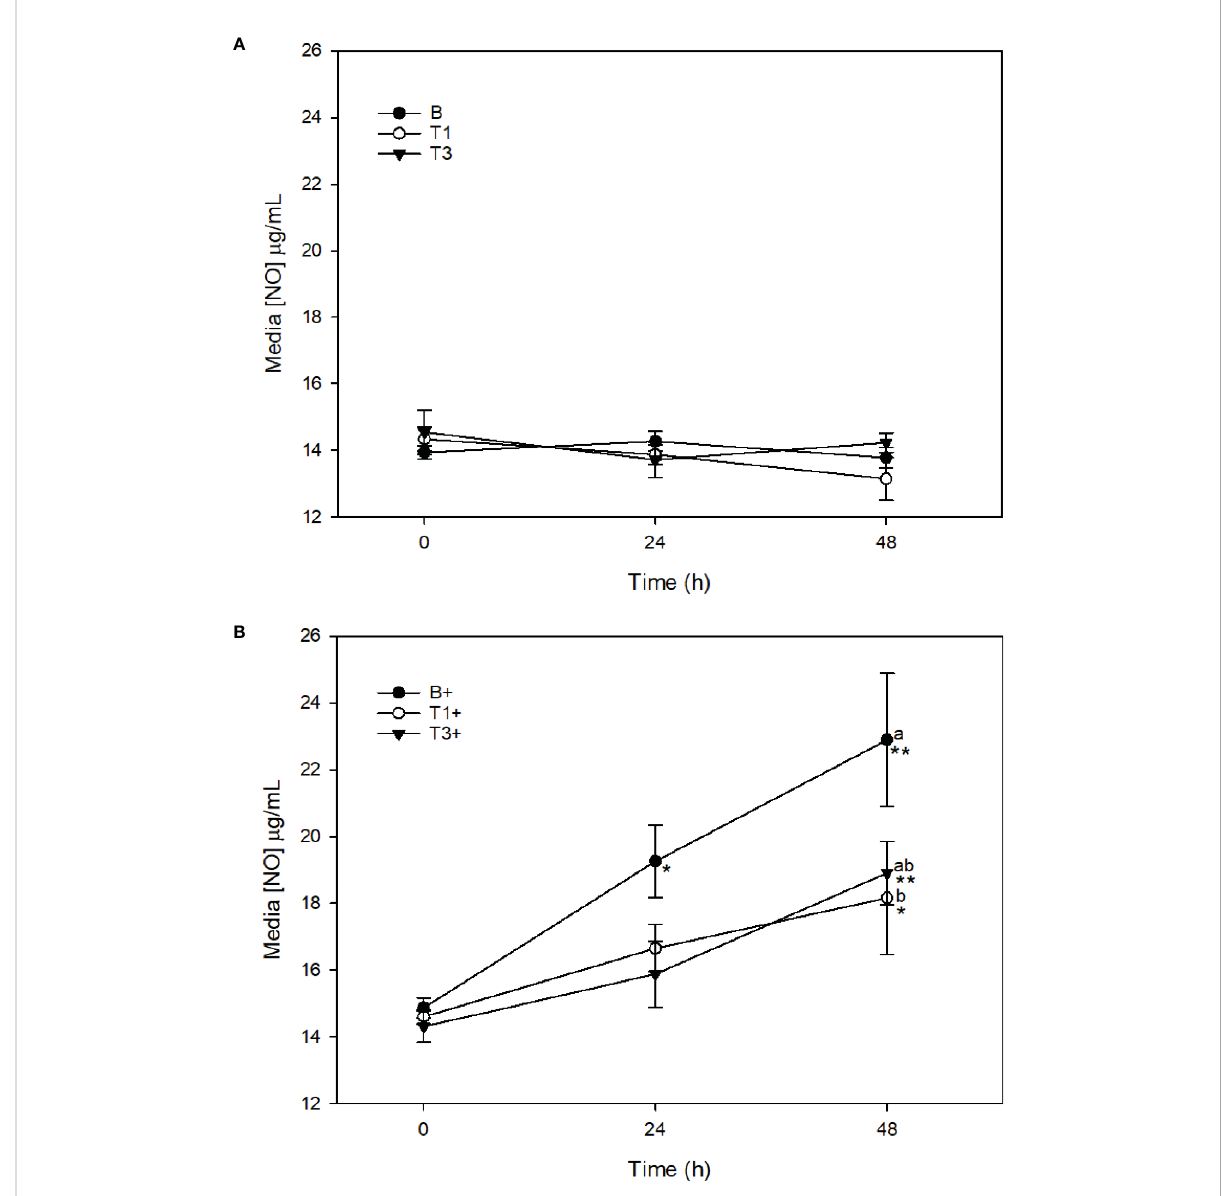
FIGURE 3 Media [NO] (µg/mL) from explants cultured in basal media (B) or media conditioned with 5 (T1) or 15 (T3) µg/mL of Wheatgrass Extract. Explants werer maintained without stimulation (A) or were stimulated with lipopolysaccharide (10µg/mL; denoted as ’ + ’ ) (B) . *denotes signi fi cant change from baseline within treatments . Letters denote signi fi cant difference between treatments at individuals time